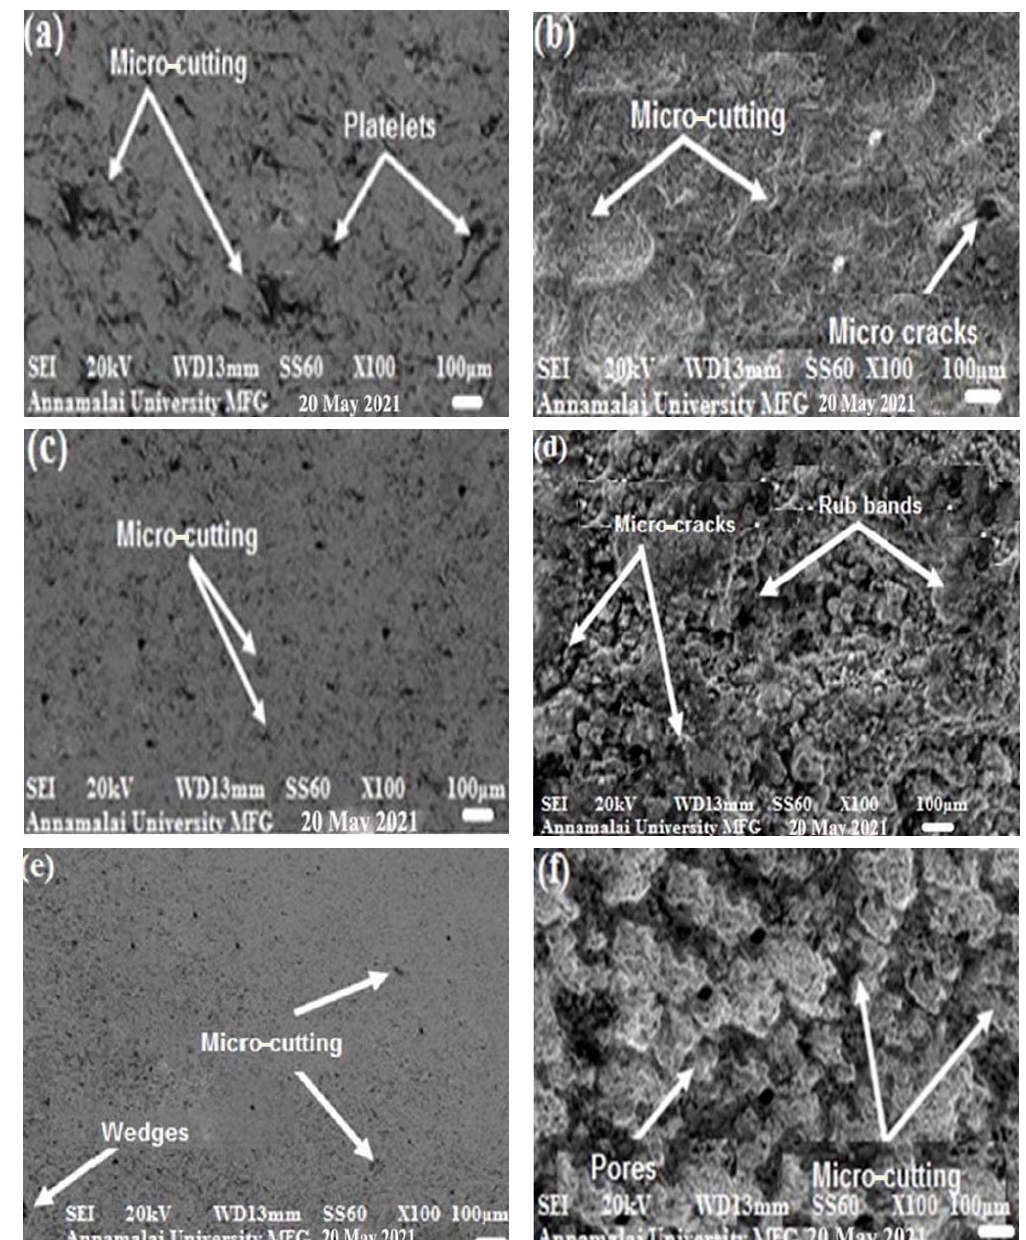
Figure 9. Worn surfaces of the coatings and substrate at different erodent discharges: ( a , c , e ) uncoated substrate; ( b , d , f ) coatings.